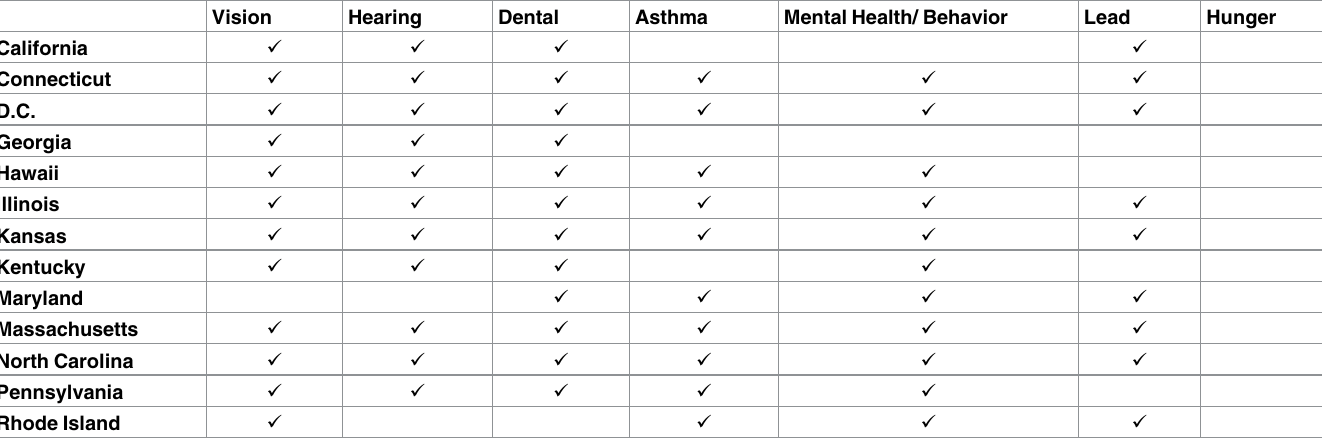
Table 2. Inclusion of specific health areason school forms from 12 states and